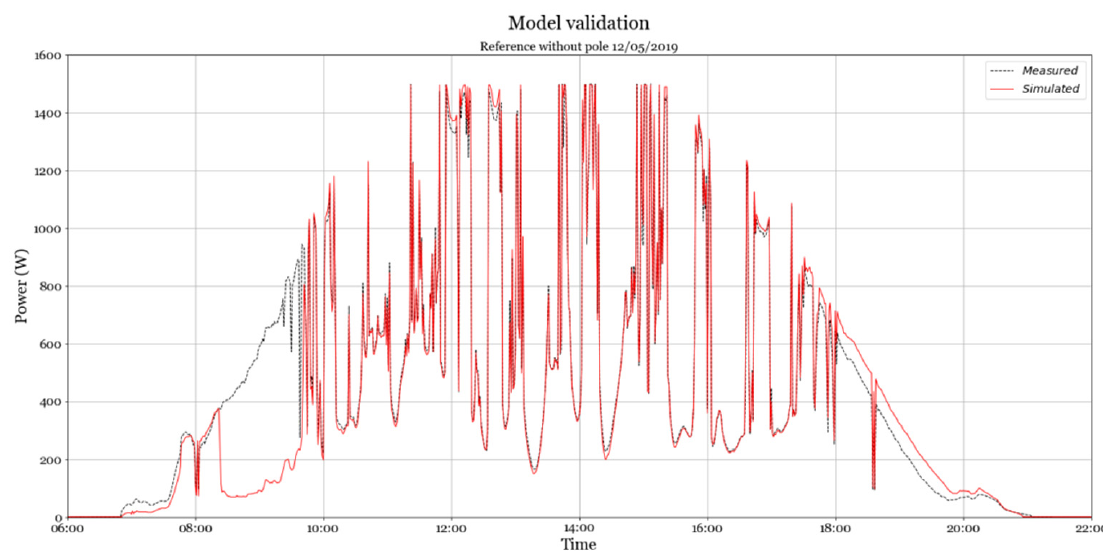
Figure 13. Simulated and measured power output for a mixed day of clouds and sun.